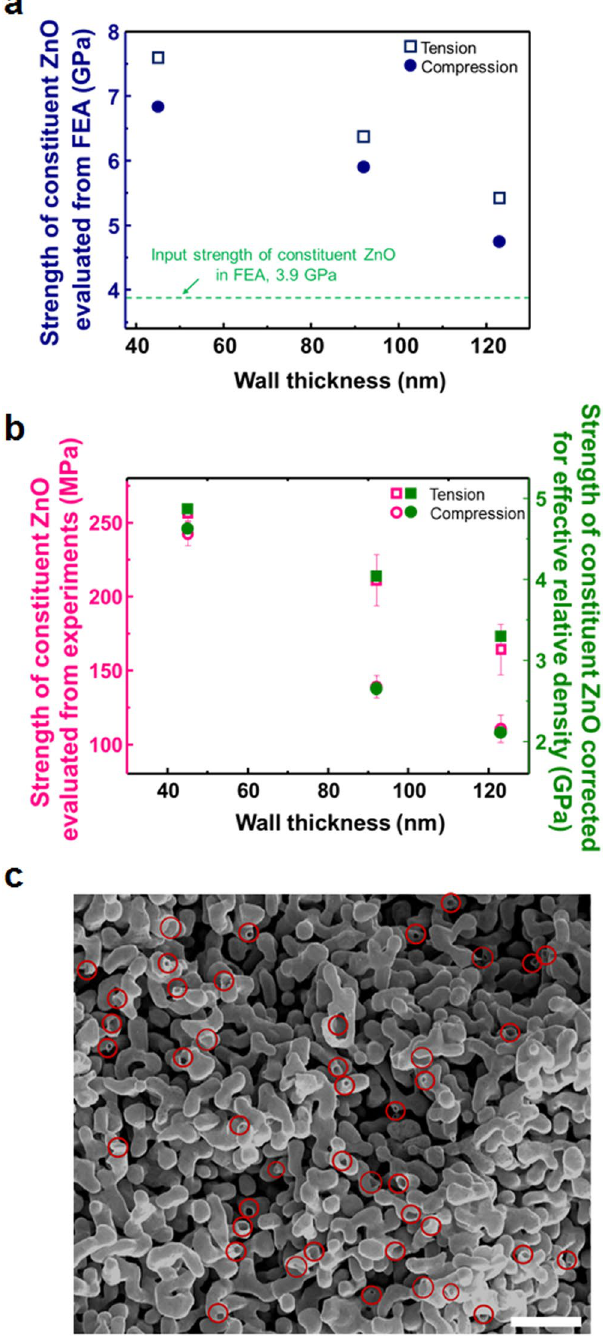
Figure 5. Strength of constituent ZnO evaluated by the Gibson-Ashby model as a function of wall thickness. ( a ) Strength of constituent ZnO in nanotubular structure evaluated from yield strengths evaluated by FEA simulations, by applying general Gibson-Ashby model σ ρ = . . 0 3 1 5 . ( b ) Strength of constituent ZnO evaluated from yield strengths measured by experiments by general Gibson-Ashby model (left y-axis), and those corrected for effective relative density as 14% of relative density in terms of volume fraction (right y-axis). ( c ) Fracture surface of nanotubular ZnO by micro-tensile testing (scale bar, 10 μ